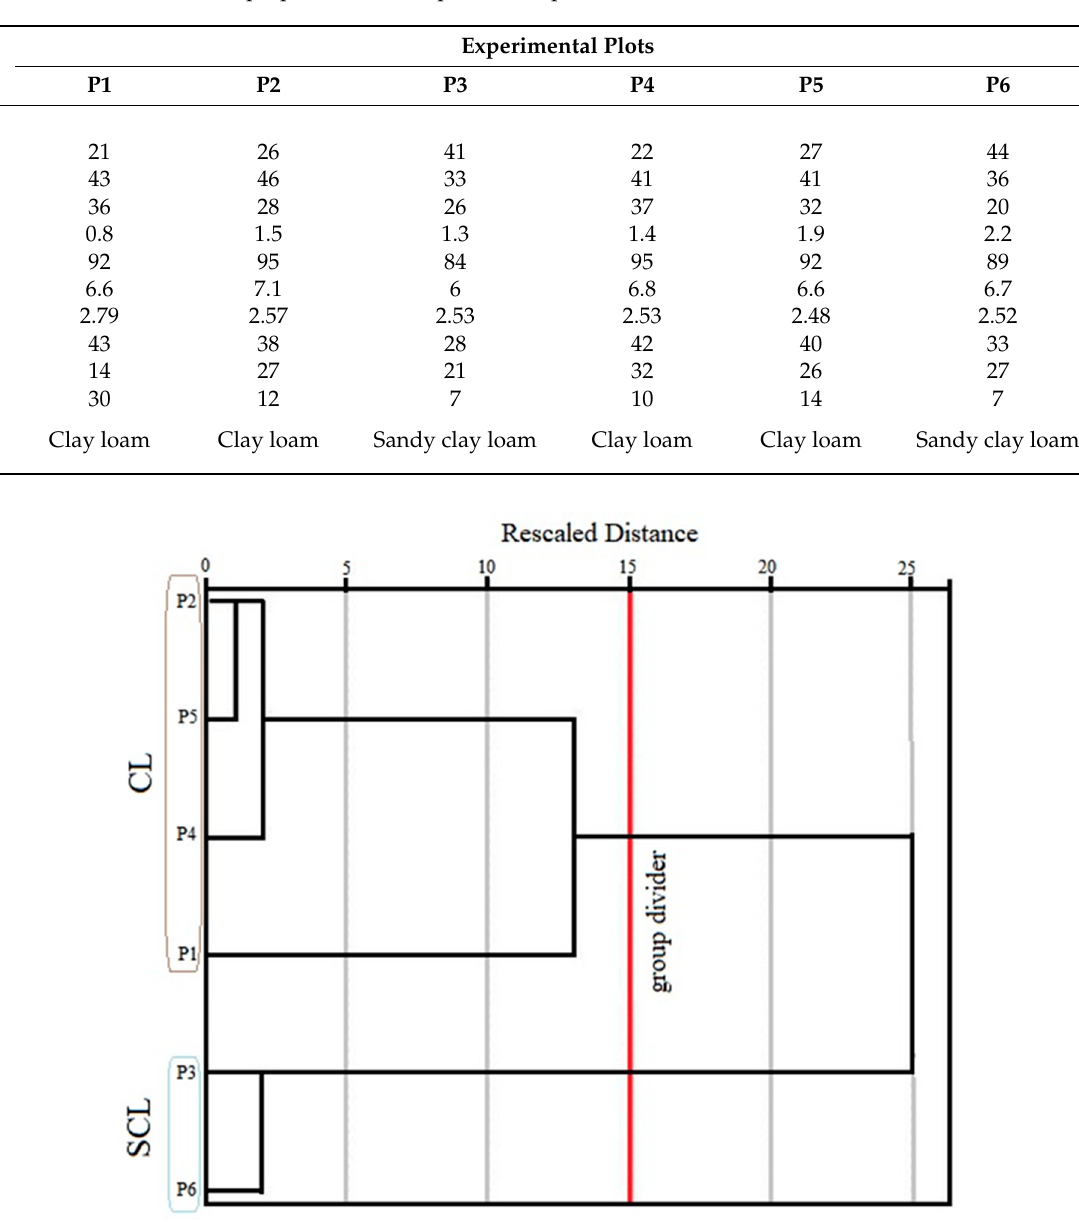
Table 2. Soil properties of the experimental plots.